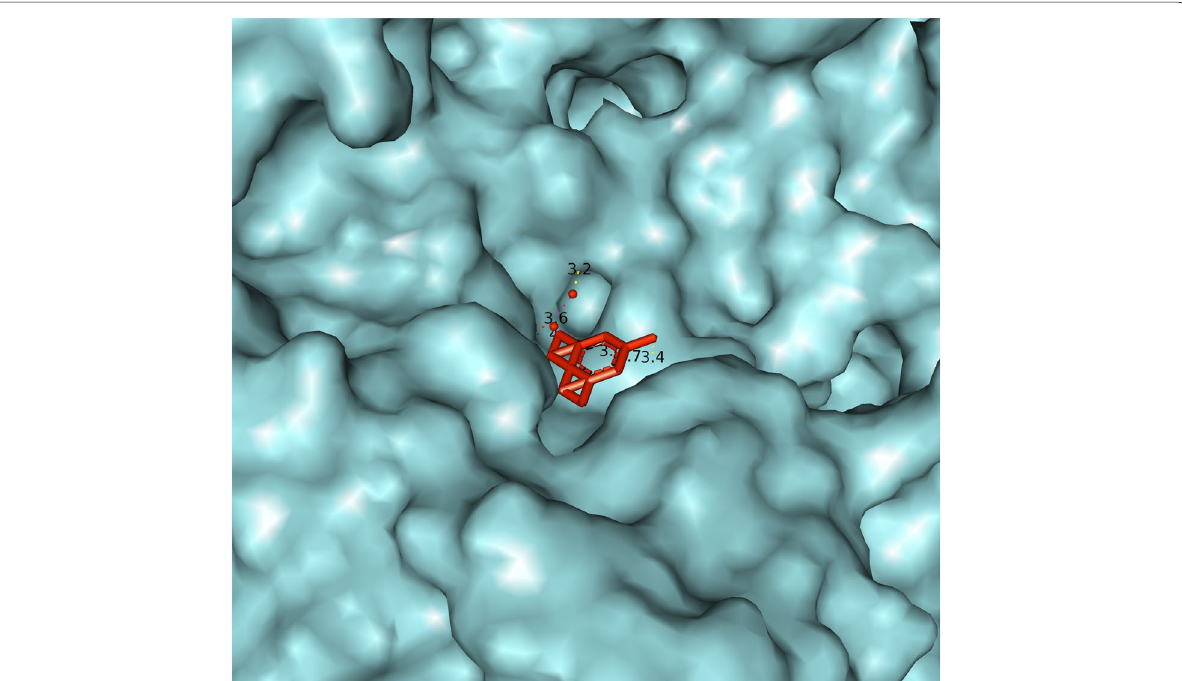
Fig. 6 Pocket which contains the molecule of halogenated boroxine interacting with the heme group of human catalase